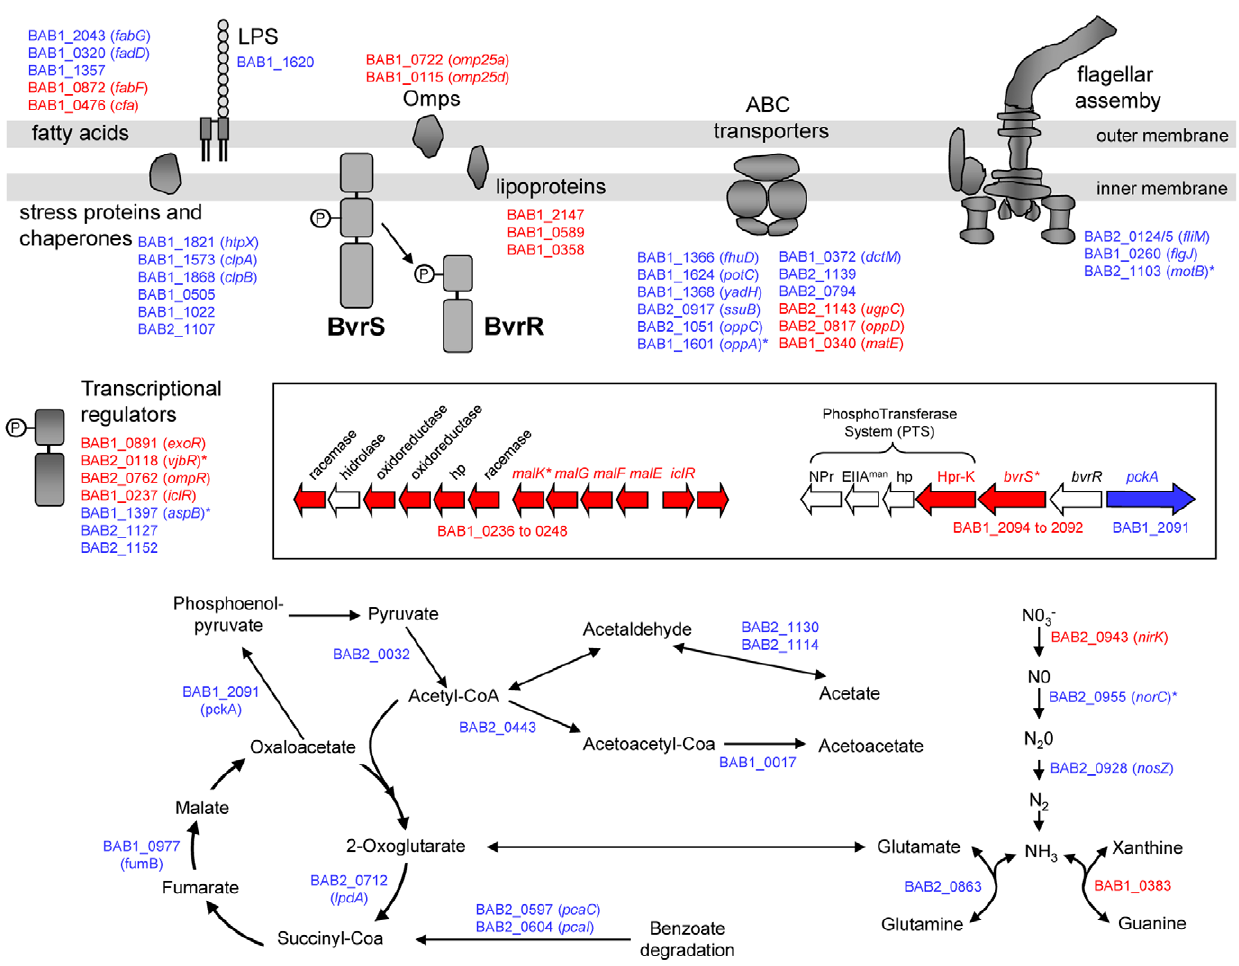
Figure 2. Schematic diagram of the candidate genes regulated by Brucella BvrR/BvrS two-component system identified in the microarray experiments. Genes up regulated are shown in blue and genes down regulated are shown in red. An asterisk shows genes that have been related previously with virulence in Brucella .